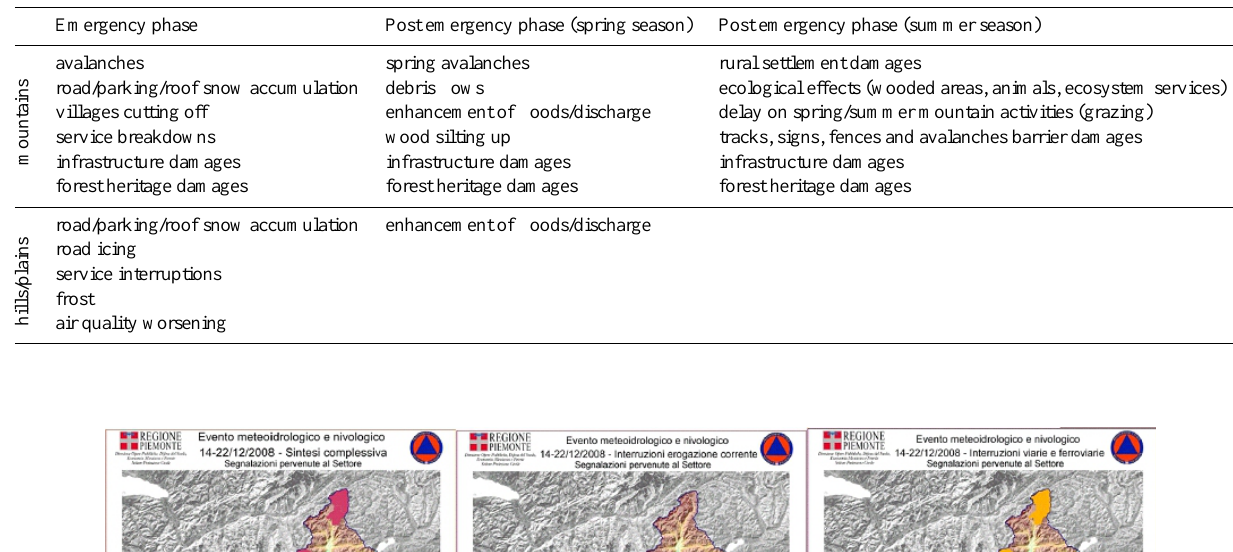
Table 3. The different impact time scales for the mountain and plain areas.